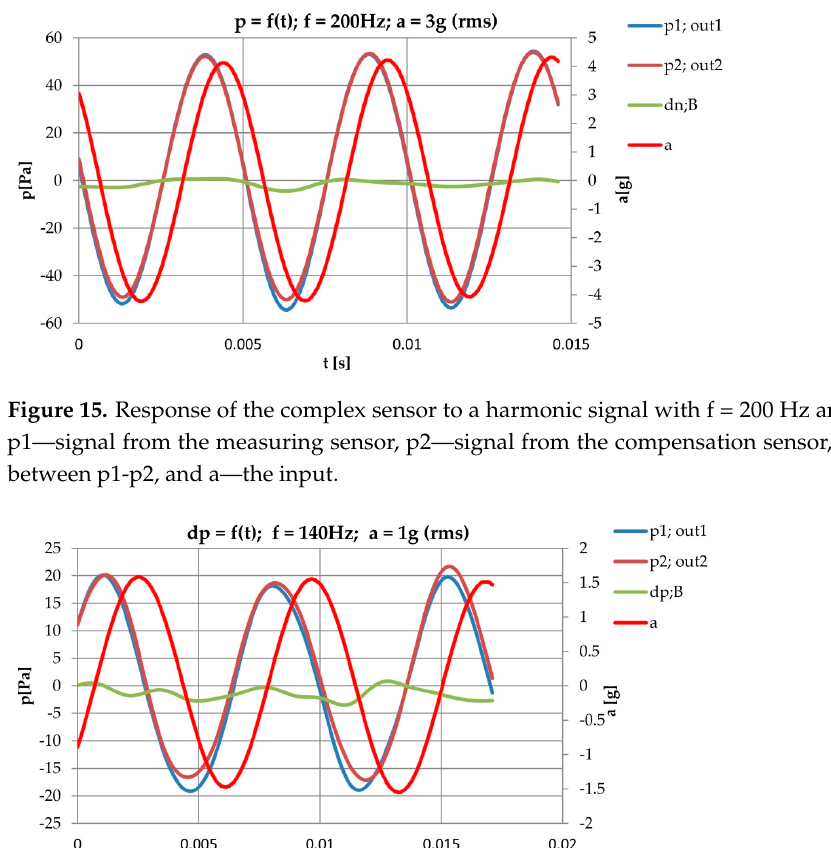
Figure 17.Response of the complex sensor to a polyharmonic signal low-frequency f = 5 Hz, a = 1g (Rms), p1- signal from the measuring sensor, p2-signal from the compensation sensor, and dp-difference between p1-p2.